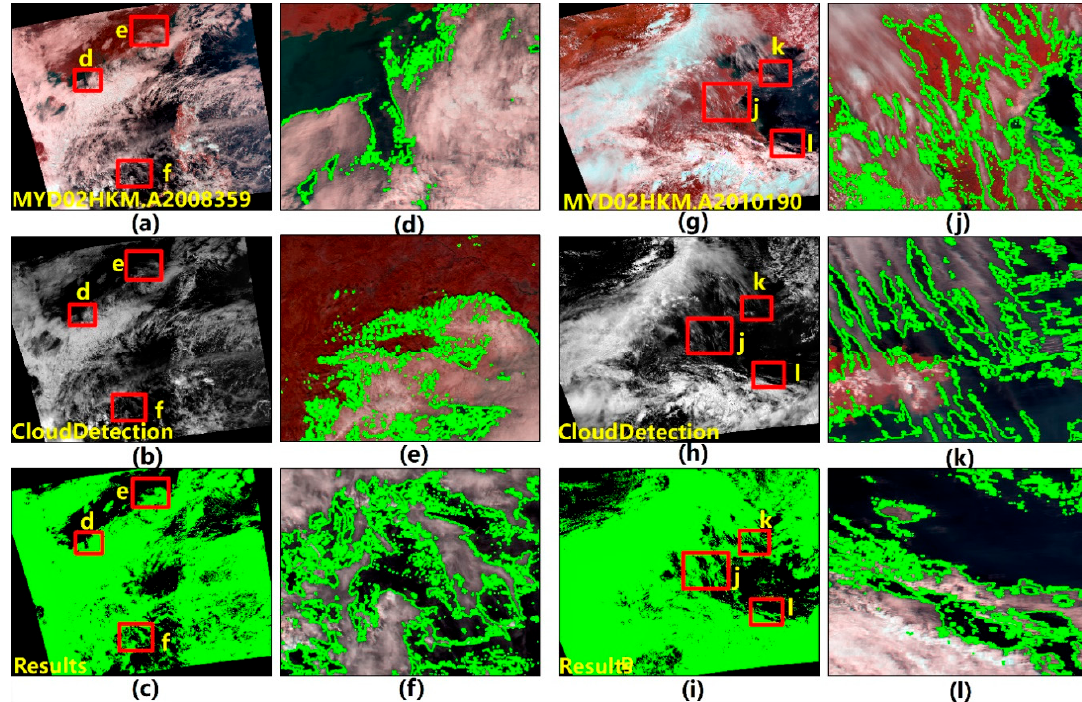
Figure 11. The original map ( a, g ) and the cloud detection results ( b, c, h, i ) obtained using the EN-Clustering method, for two selected Aqua-MODIS images. ( a and g ) The utilized MODIS data (Table 2); ( d ) the cloud detection results for thick clouds over the coastal area of the SCS; ( e ) cloud detection results for thin and thick clouds over the land region; ( f ) a large area of thin clouds over the ocean; ( j ) cloud detection results for thin clouds over the land; ( k ) cloud detection results over the coastal area; and ( l ) thin cloud, thick cloud, and broken cloud detection results over the ocean;